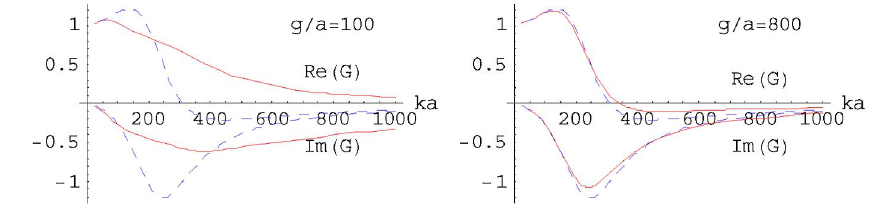
FIG. 4. (Color) The dashed curves representing the equilibrium approximation G 1 [Eq. (1.3)] are seen to be in agreement with the solid curves representing the real and imaginary parts of the function G as determined from a numerical solution of the truncated linear algebraic equations when ka (cid:4) g=a . Results are for a (cid:5) 0 : 01 m and (cid:3) (cid:5) 10 6 (cid:1) ohm m (cid:3) (cid:6) 1